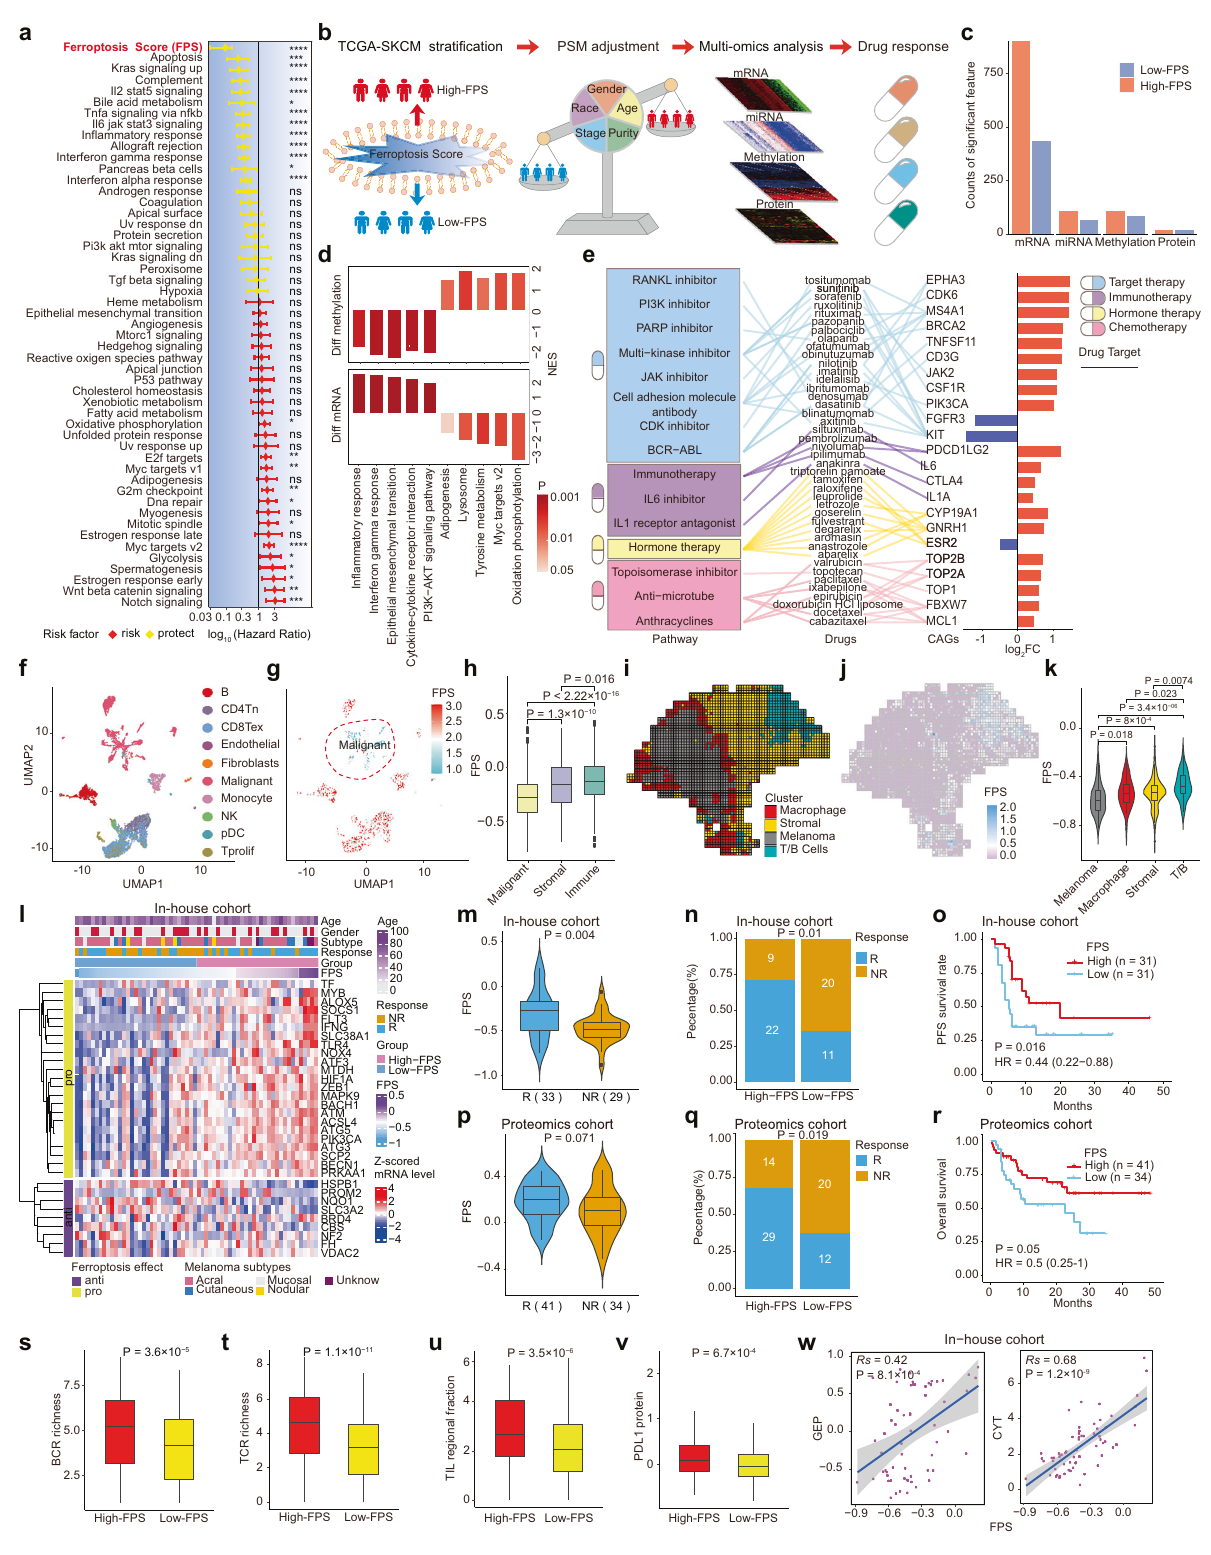
10c) and associated with bene fi t of anti-PD-1 therapy (Fig. 1p – r). Taken together, these fi ndings suggest the robustness of the FPS model as a potential biomarker to predict immu- notherapy response based on bulk, single-cell transcriptome, and proteomic-level